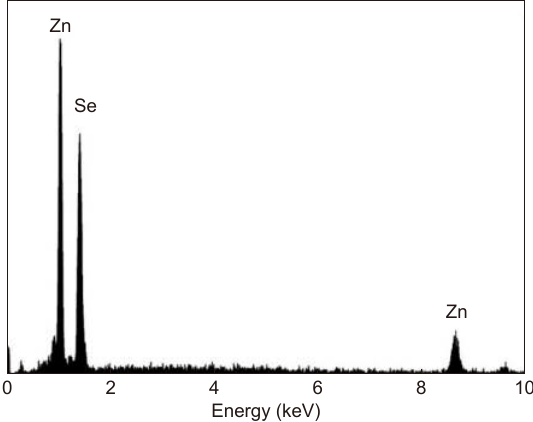
Fig. 2 | EDX image of 0.5 mm thick polycrystalline ZnSe.